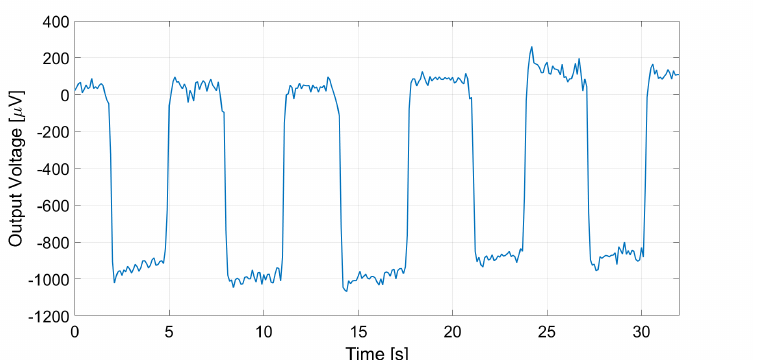
Figure 15. Measured 3–T TMOS output in the case of a hand moved in front of the sensor at 5 cm distance.